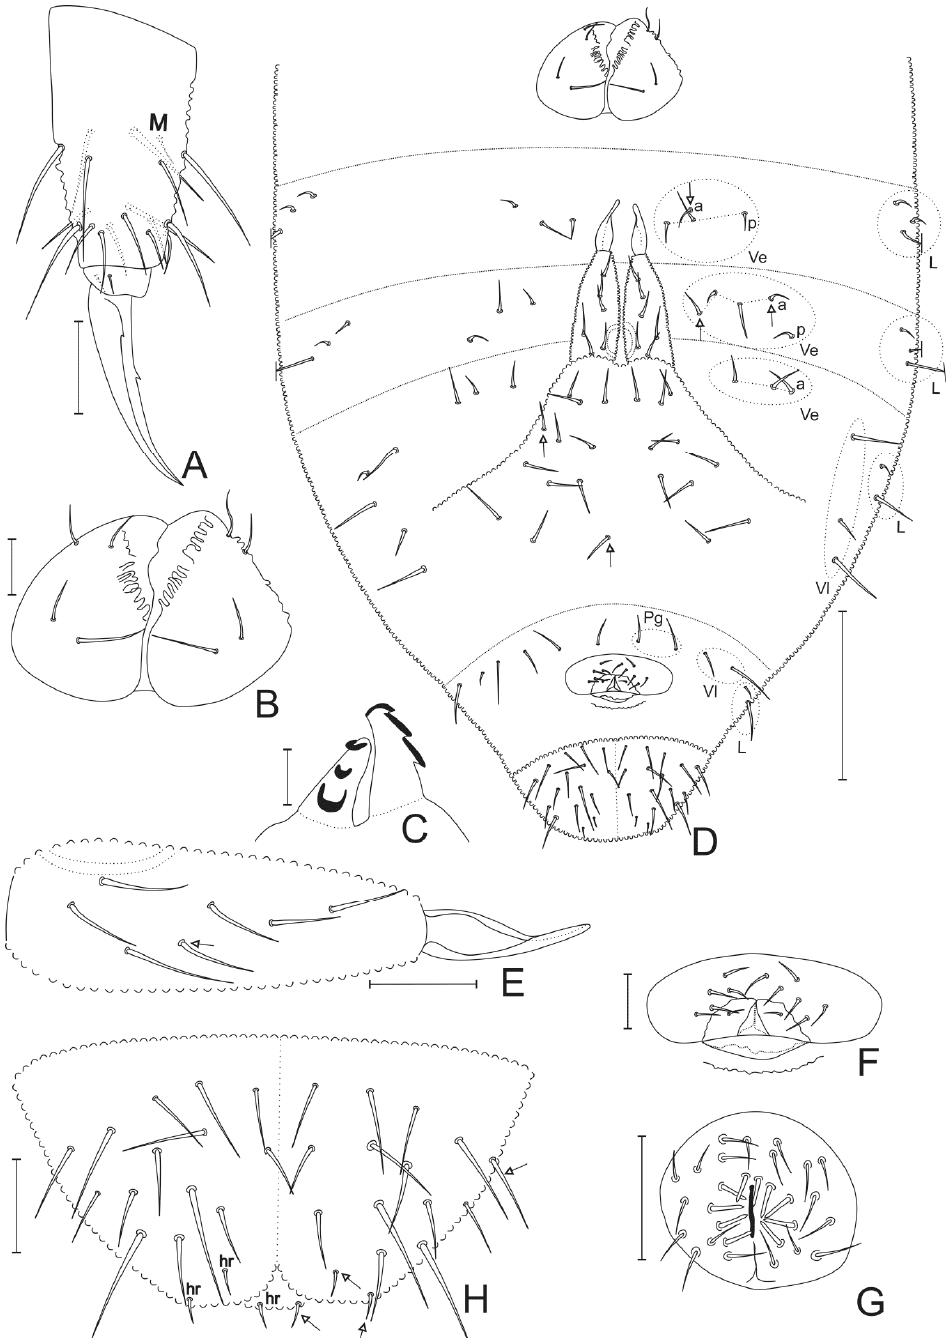
Figure 3. Neotropiella arretada sp. nov.: ( A ) tibiotarsus and empodial complex III (inner view); ( B ) ventral tube; ( C ) tenaculum rami and corpus; ( D ) ventral abdominal chaetotaxy, tenaculum omitted; ( E ) right dens and mucro, dorsal view; ( F ) female genital plate; ( G ) male genital plate; ( H ) ventral anal valves and hr chaetae on dorsal anal valve. White arrows point to chaetae present or absent. Scale bars: 5 μ m ( C ); 10 μ m ( F ); 20 μ m ( A–B, E, G–H ); 100 μ m ( D ).